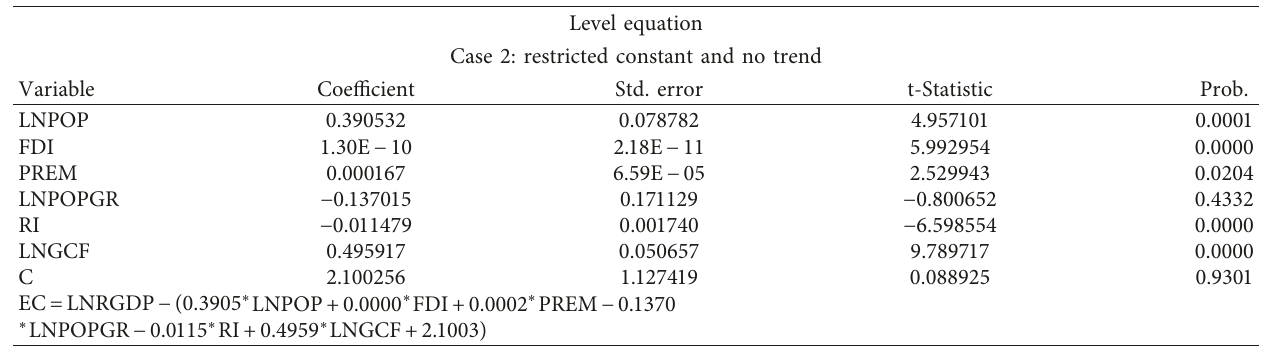
Table 5: Results of the ARDL coefficient of long